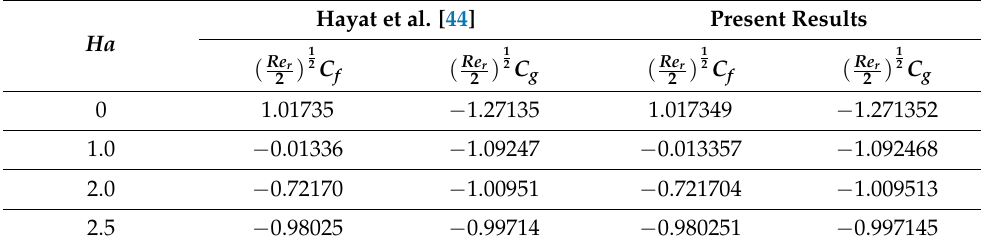
1 1 ) ( Re r ) 2 C 2 C g values for different values of Ha with those of f and 2 2 Hayat et al.